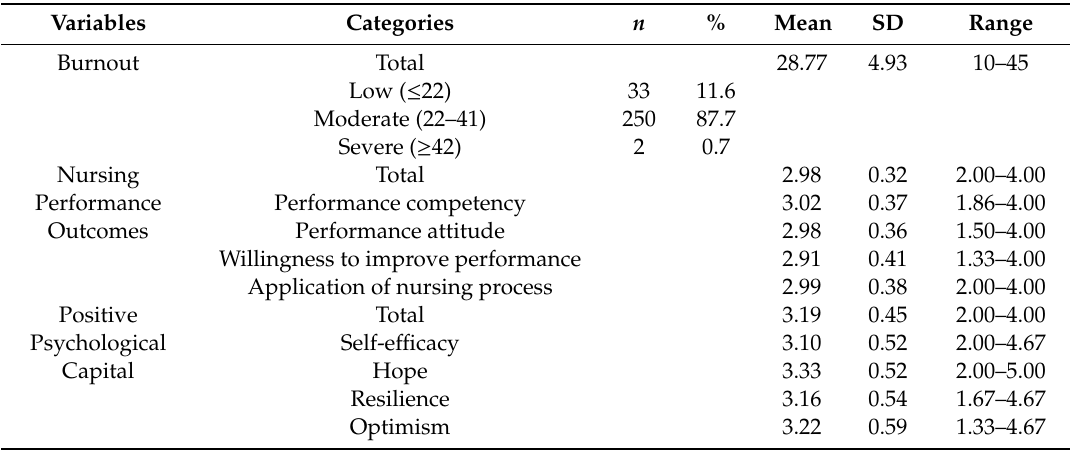
Table 2. Burnout, nursing performance outcomes, and positive psychological capital of participants ( n =